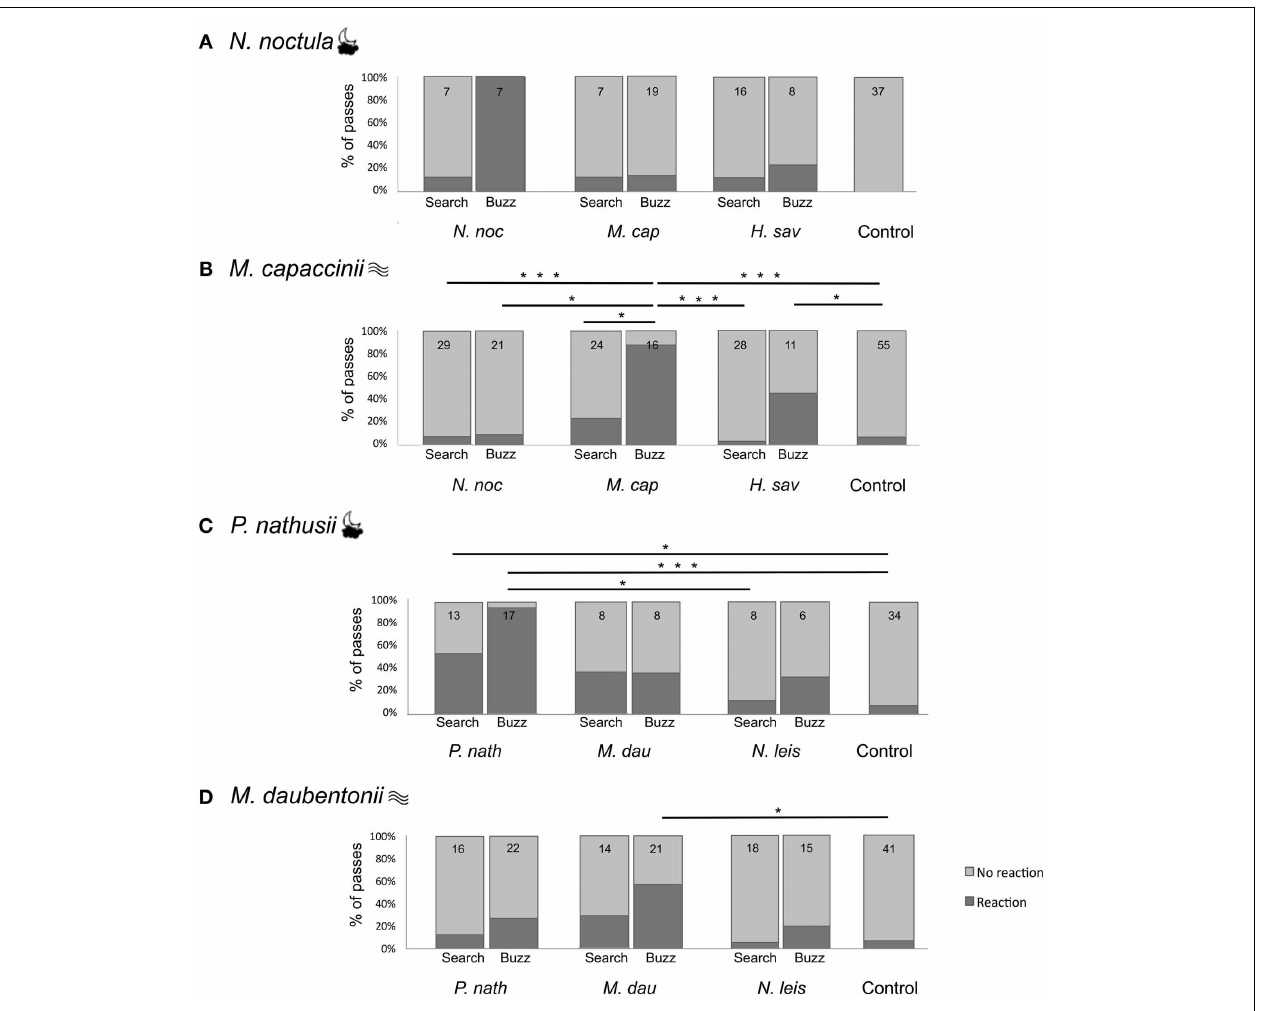
FIGURE 2 | Percentage of bat passes showing a reaction (dark gray) and no reaction (light gray) in response to the playback of echolocation calls of different species. (A) Reactions of N. noctula and (B) M. capaccinii in Bulgaria. (C) Reactions of M. daubentonii and (D) P. nathusii in Germany. The focal species is indicated at the top left of each panel, with symbols indicating its foraging style [cloud ( ) = open-space